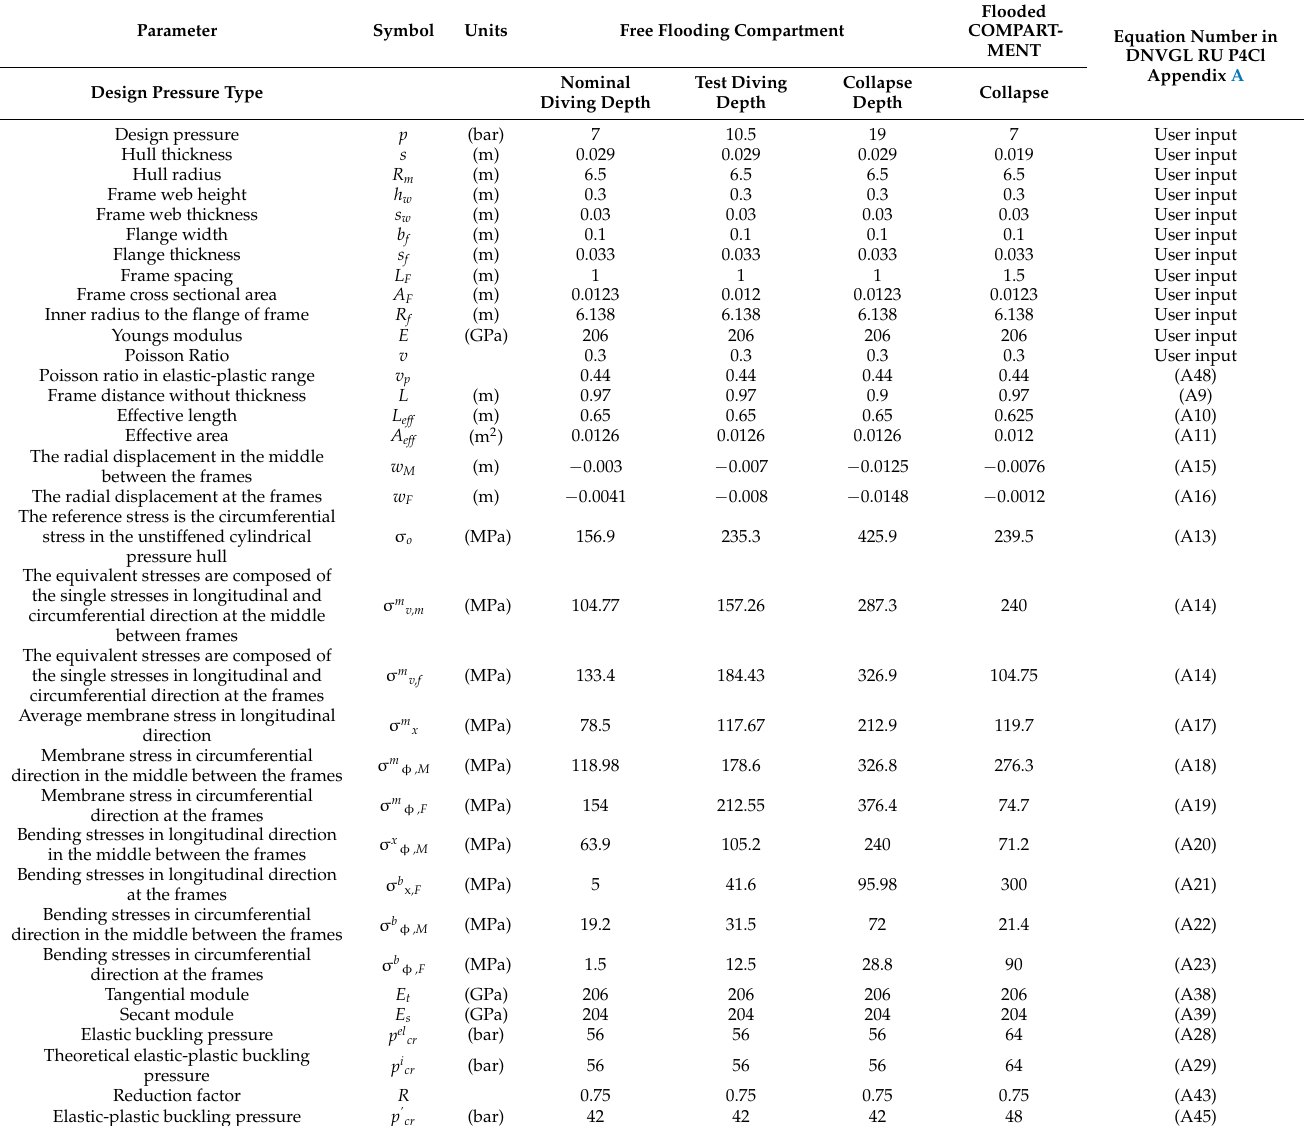
Table A1. External hull calculation for SST 1: Subsea shuttle tanker (Cargo 10 569 m 3 ).